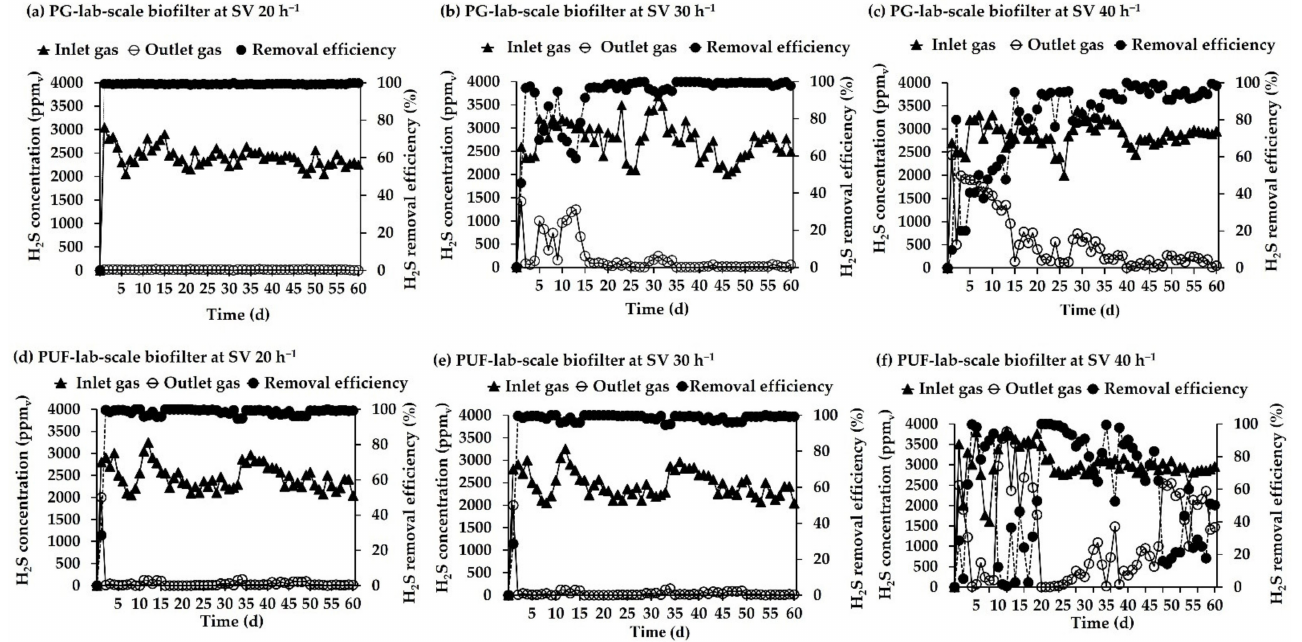
Figure 4. Inlet/outlet of H 2 S and efficiencies of H 2 S removal in the lab-scale biofilters packed with immobilized cells P. versutus CM1 on PG under different SV conditions: ( a ) 20 h − 1 , ( b ) 30 h − 1 , and ( c ) 40 h − 1 and on PUF under different SV conditions: ( d ) 20 h − 1 , ( e ) 30 h − 1 , and ( f ) 40 h − 1